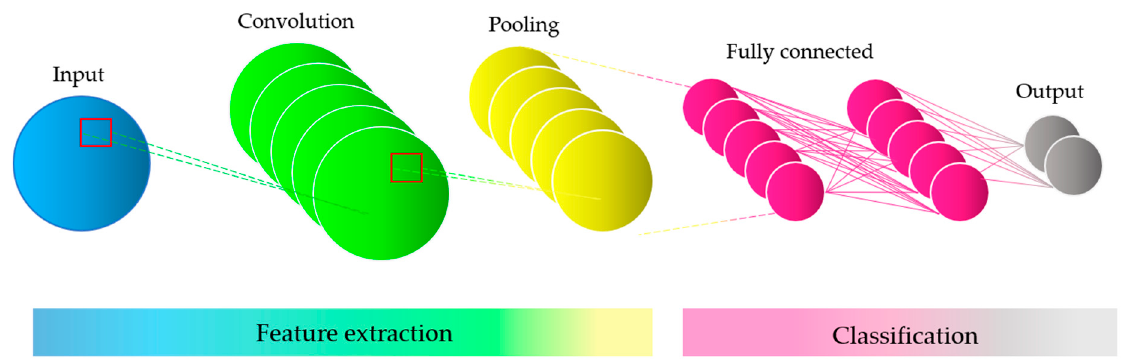
Figure 7. Convolutional neural network architecture.